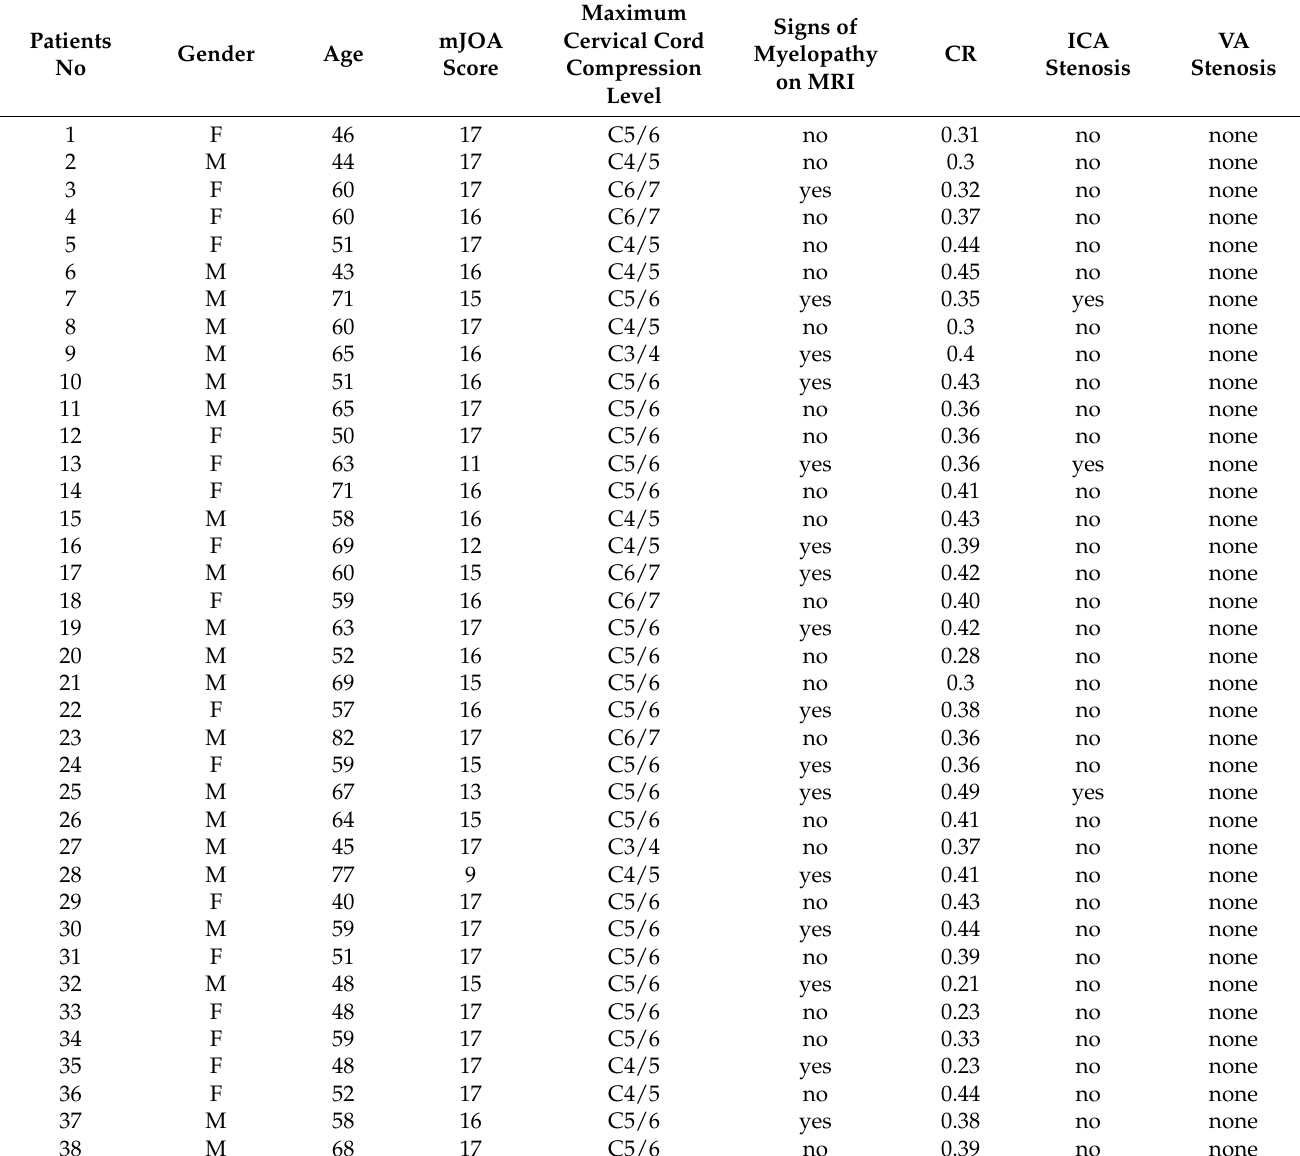
Table 1. Demographic and imaging